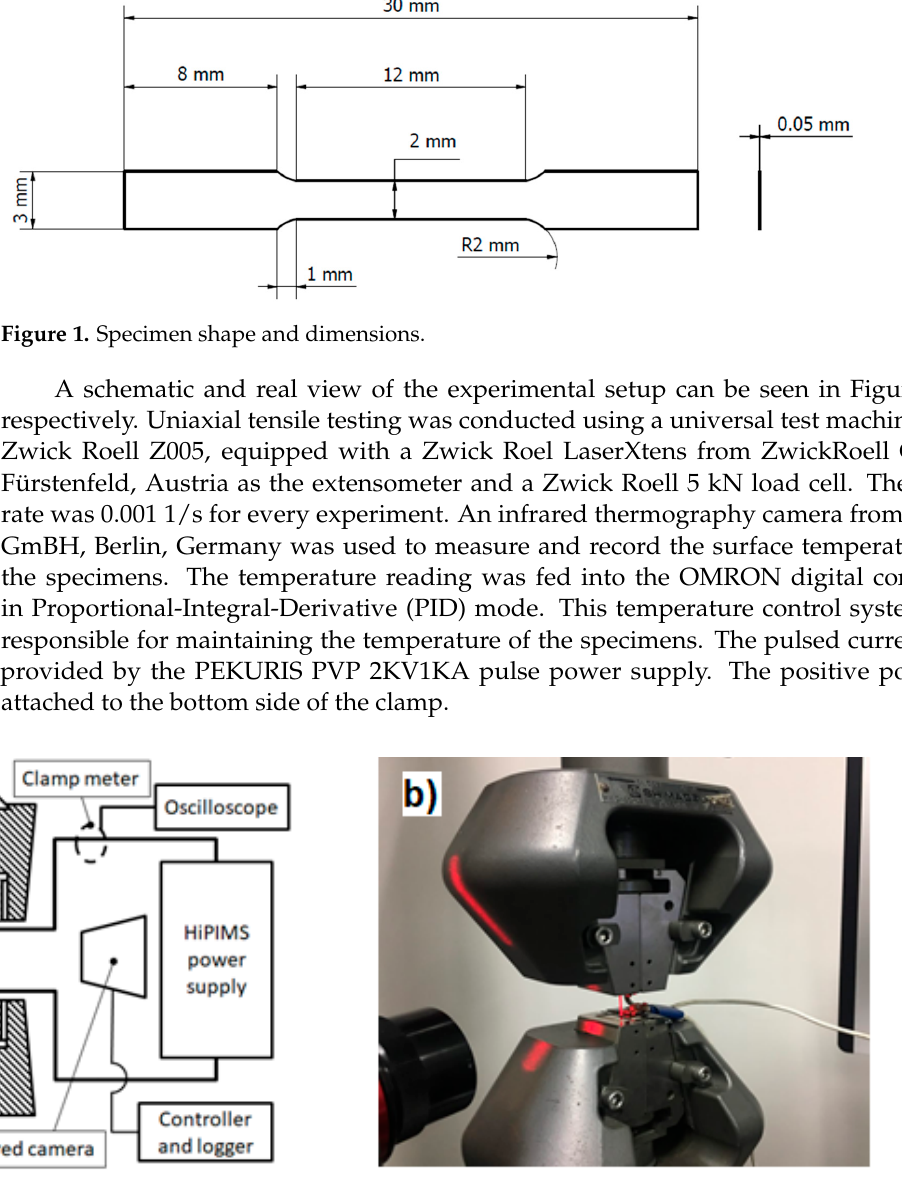
Figure 2. ( a ) Schematic and ( b ) real view of experimental